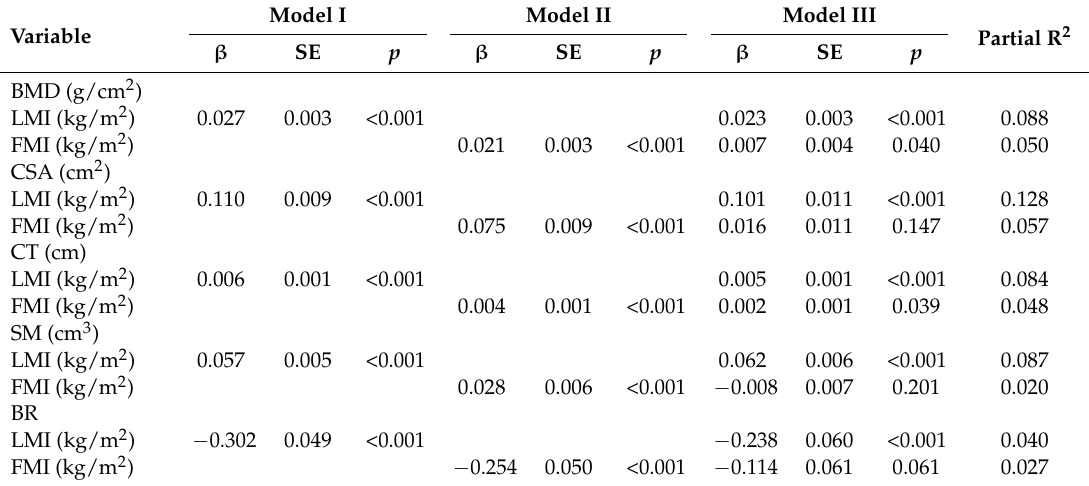
Associations between bone phenotypes and FMI or LMI in the multiple linear regression